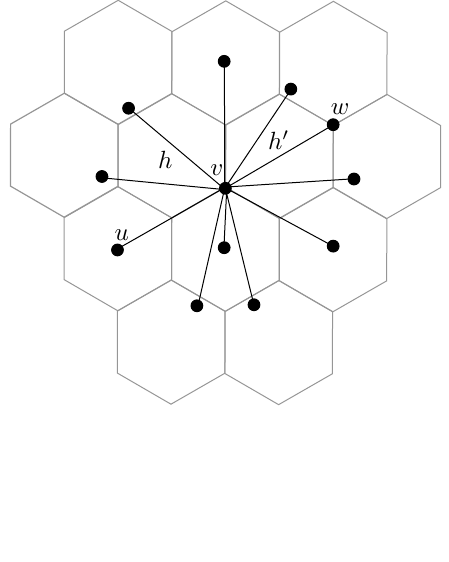
Figure 4 . Tight example for Algorithm 1. To make the figure clearer the edges which are not adjacent to v are omitted.